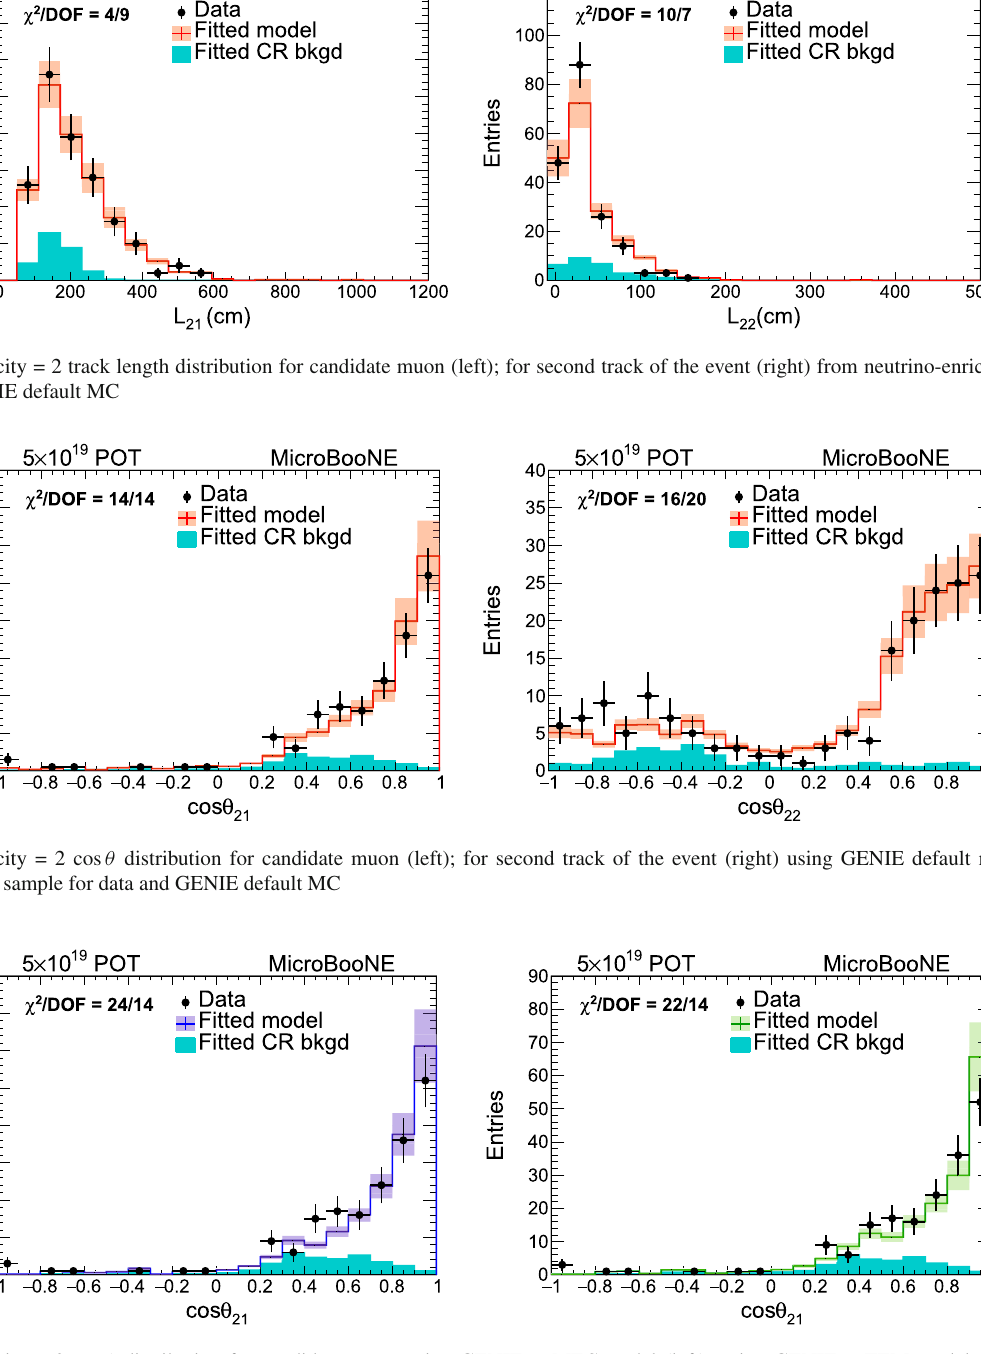
Fig. 19 Multiplicity = 2 cos θ distribution for candidate muon using GENIE + MEC model (left); using GENIE + TEM model (right) from neutrino-enriched